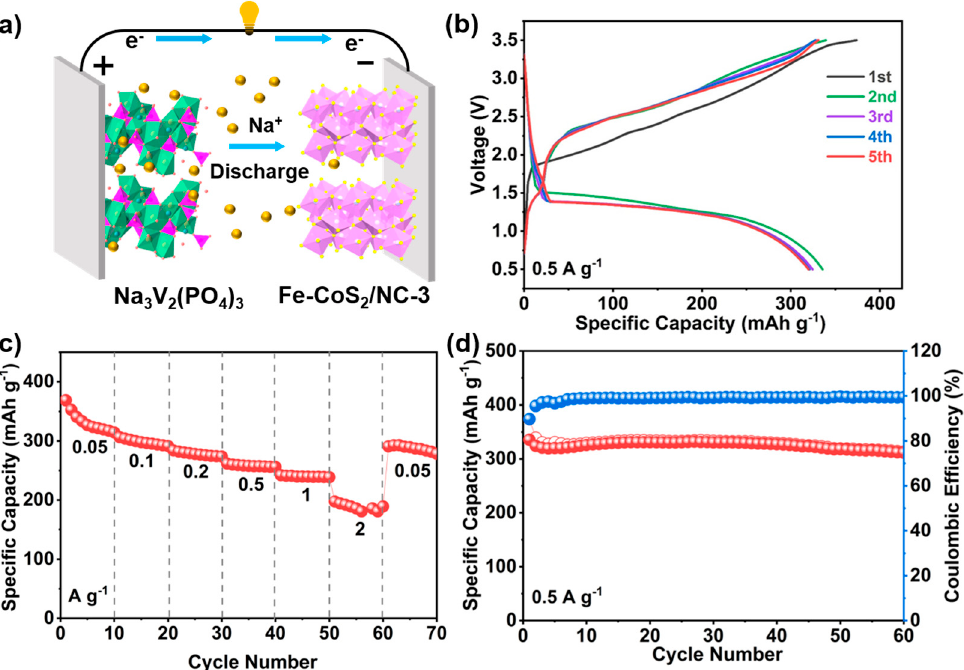
Figure 6. Electrochemical performance of the Fe-CoS 2 /NC-3//NVP full SIBs: ( a ) schematic diagram of the full ba tt ery, ( b ) initial fi ve cycles of GCD curves at 0.5 A g − 1 , ( c ) rate capability, and ( d ) cycling stability at 0.5 A g − 1 .